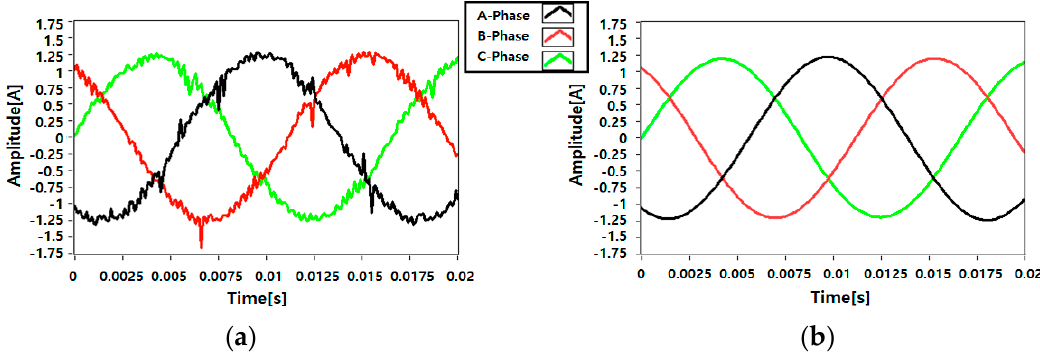
Figure 9. Filtering process for noise in the input power: ( a ) before filtering and ( b ) after filtering.